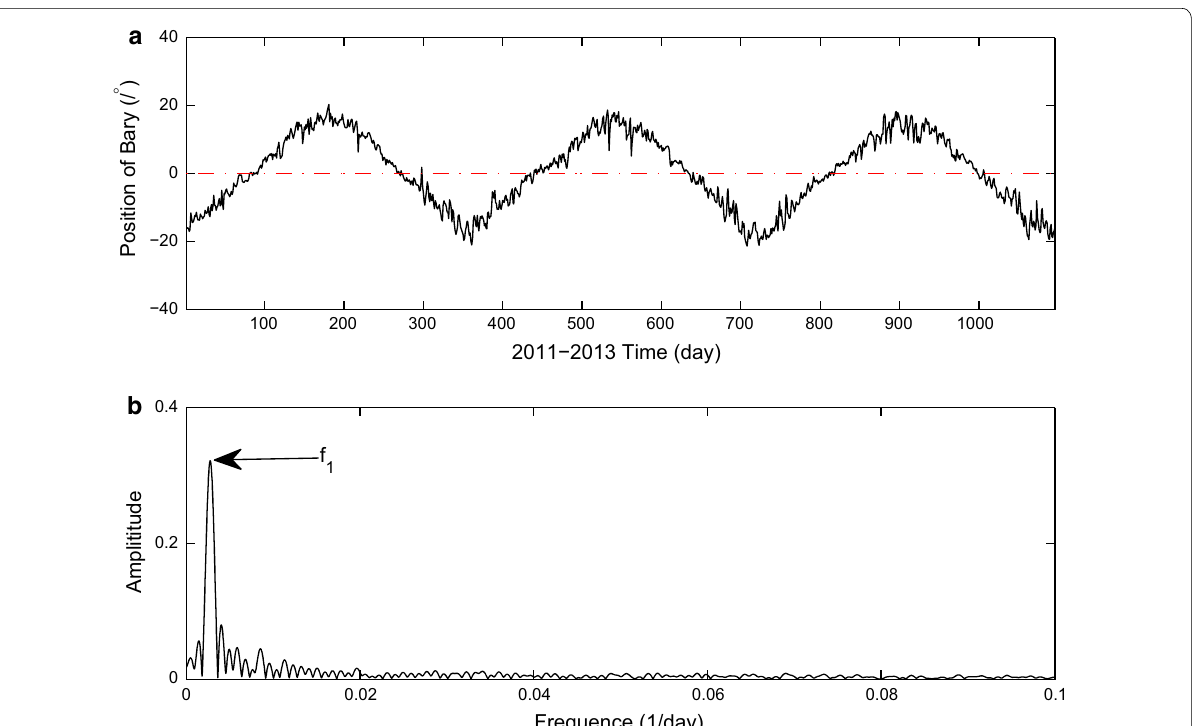
Fig. 6 The daily variation in the barycenter positions of U ( 3 ) from 2011 to 2013. a Temporal variations. b The frequency spectra calculated by Fourier